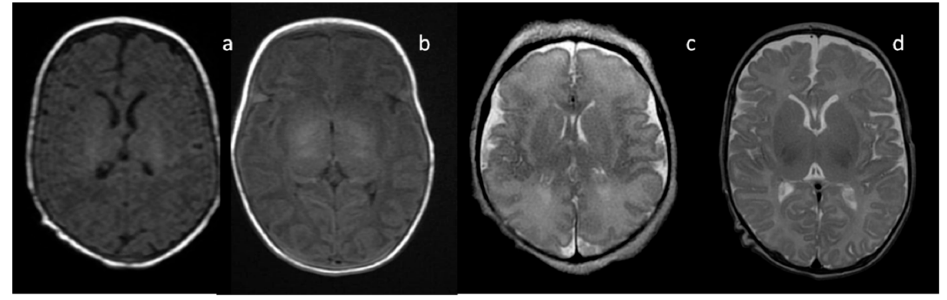
Figure 2. Infant brain MRI—no differences in signal intensity between the basal ganglia and the